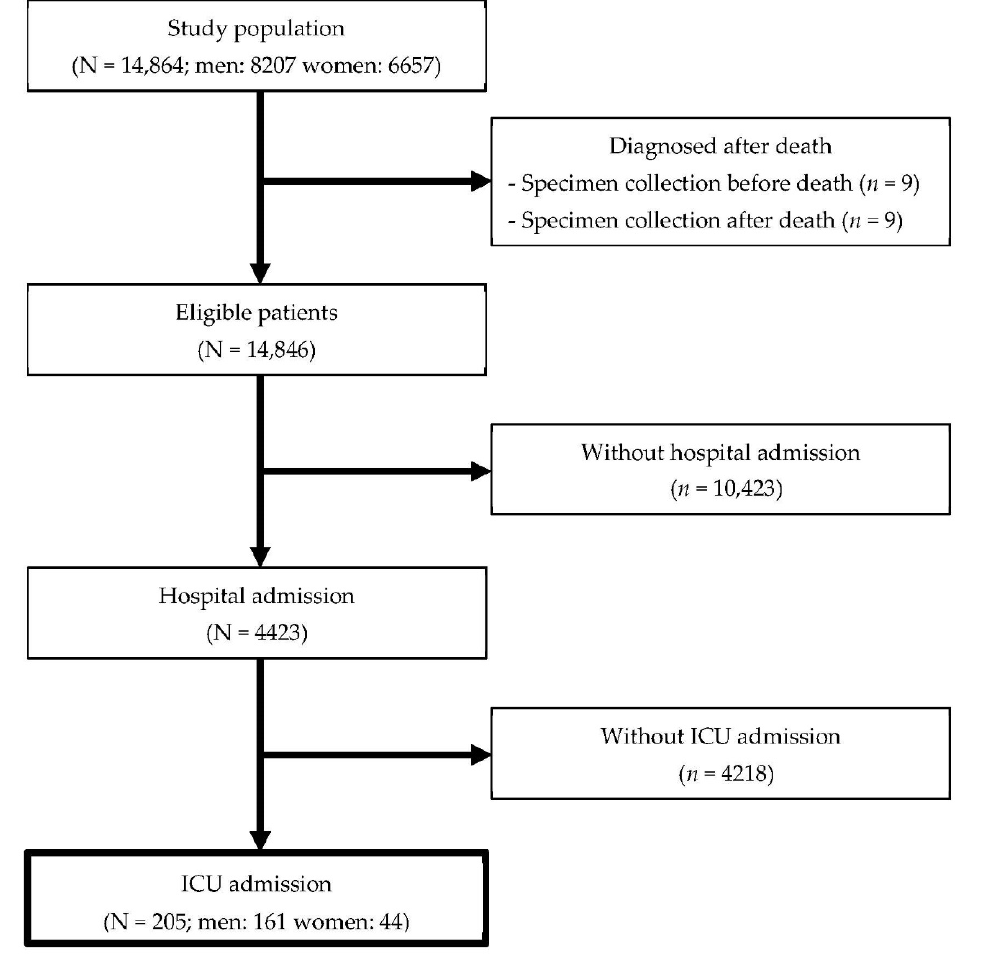
Figure 1. Flow diagram of patients admitted to the intensive care unit.